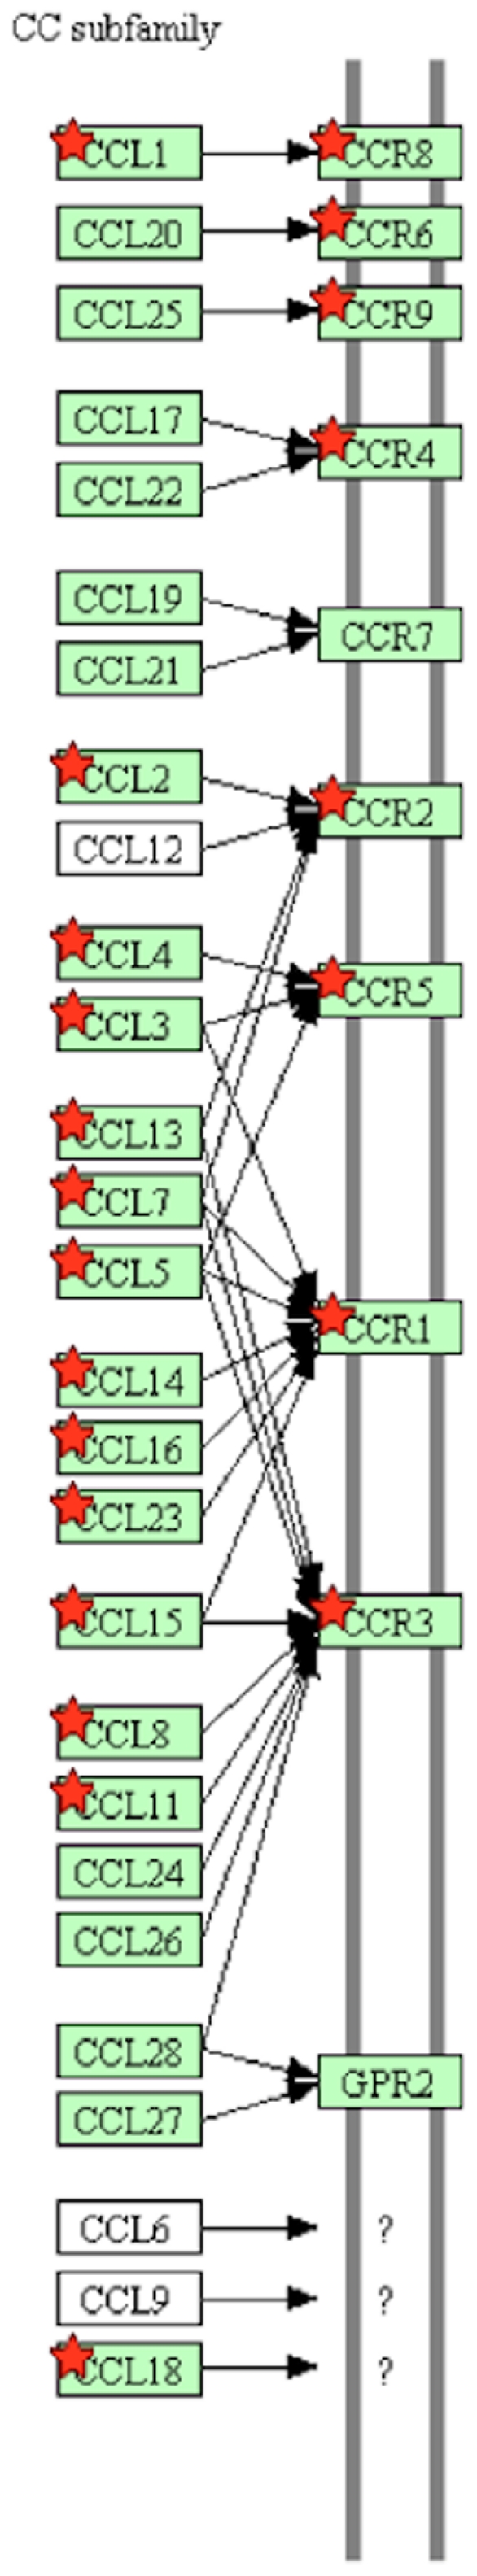
The CC chemokine subfamily deletions in primary but not metastatic tumors.Large numbers of CC subfamily chemokines and there receptors were deleted (starred red) in the primary tumor but not in matched peritoneal metastasis.